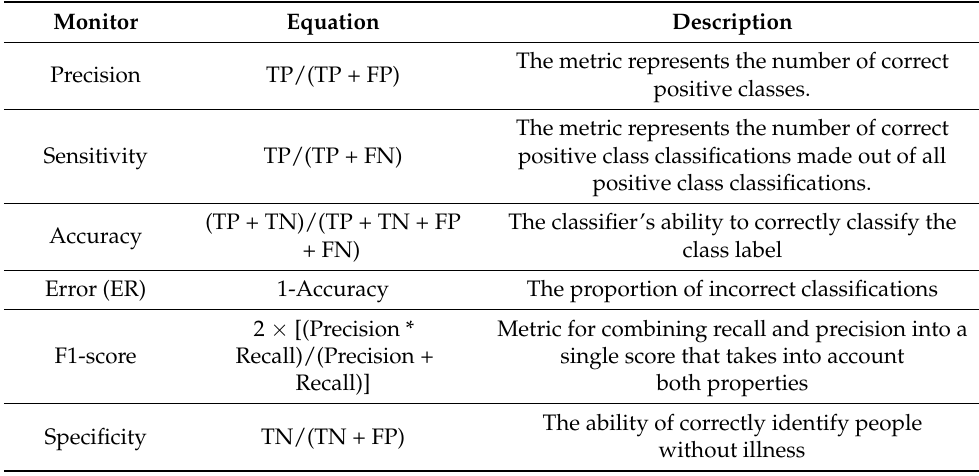
Table 3. Equations for confusion matrices with